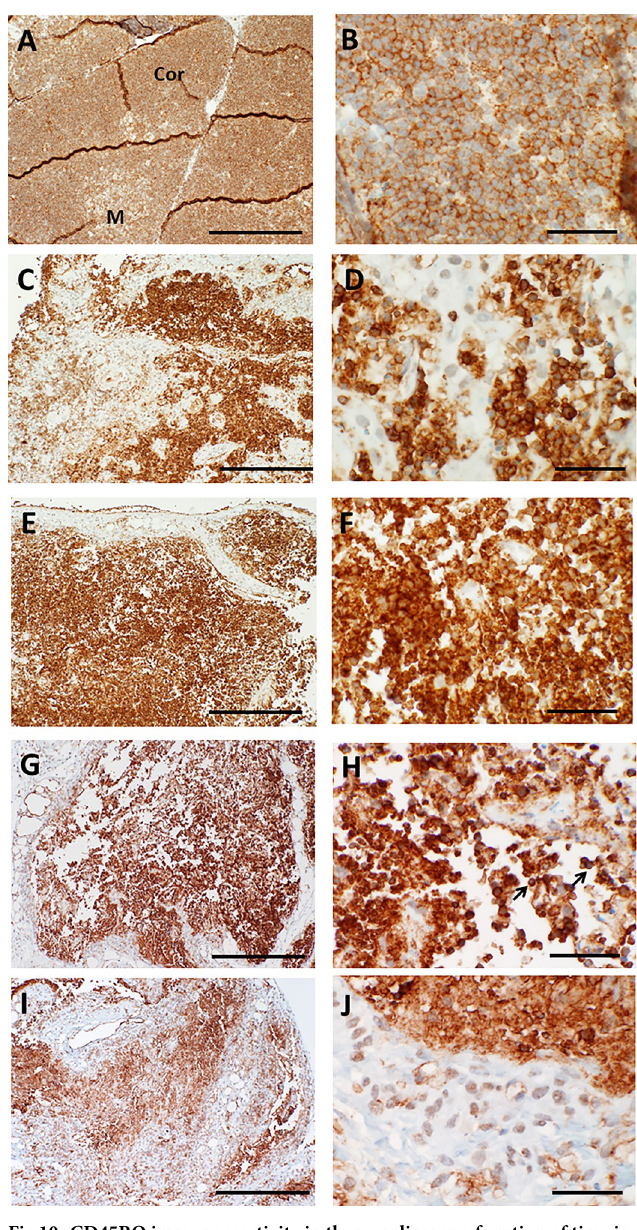
Fig 10. CD45RO immunoreactivity in thymus slices as a function of time in culture. A, B. On day 0, essentially all immature T cells in the cortex (Cor) and medulla (M) react strongly with antibody specific for CD45RO. Higher magnification (B) shows the strong brown positive membrane reactivity. C, D. By day 7, reactivity with CD45RO antibody is strongest in the medulla. Some positive cells exhibit the expected specific membrane staining, but there is also considerable reactivity with cellular debris. Loss of membrane immunostaining and intense reactivity primarily with residual thymocyte debris is seen on days 9 (E, F), 12 (G, H) and 21 (I, J), although some cells with intact membrane staining can occasionally still be detected (arrows in H). Bar represents 500 μ m in panels A, C, E, G, and I and 50 μ m in B, D, F, H, and J. clinical outcome of long-lasting immune reconstitution [5] suggests that thymic epithelial pro- genitors are likely present within transplanted thymus slices, the precise phenotype for such progenitors has not been definitively identified in humans. The phenotype of thymic epithelial progenitors in mice is still controversial [19–22] and only low numbers have been detected